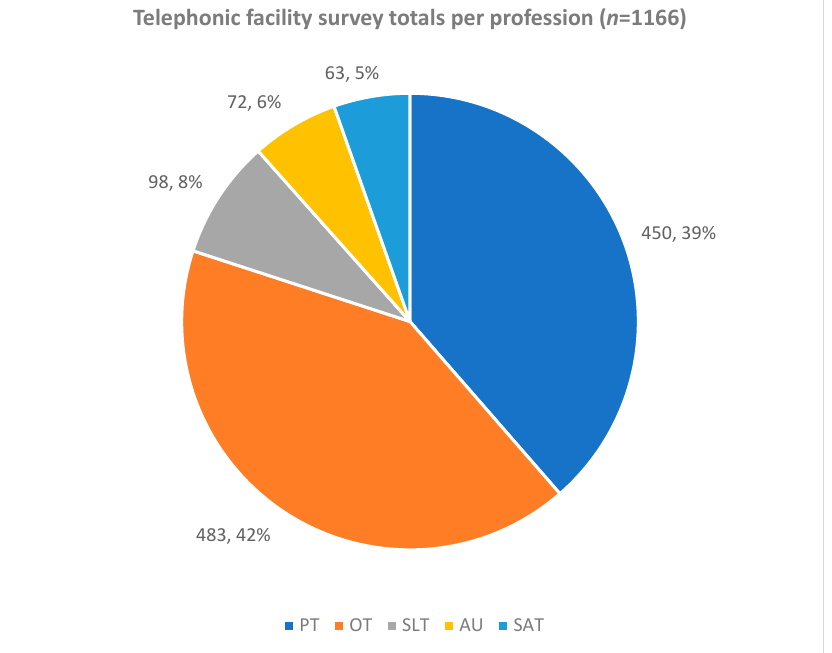
Figure 3. Distribution of salary levels per profession type. Legend: PT—physiotherapy, OT—occupational therapy, SLT—speech–language therapy, AU—audiology and SAT—speech and audiol- ogy therapy.